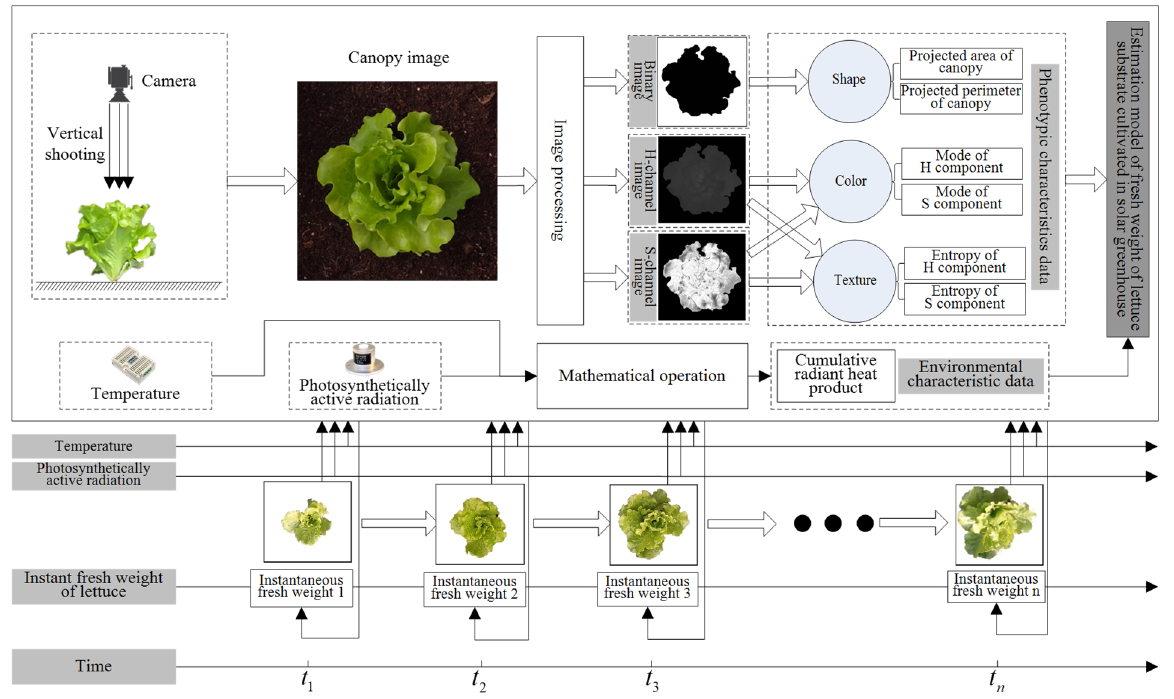
Figure 2. Schematic diagram of calculation of instantaneous fresh weight.